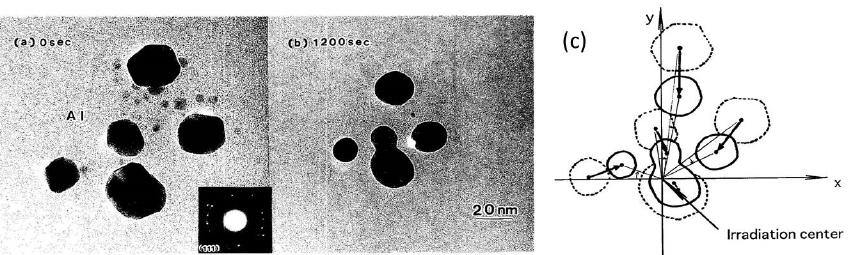
Figure 5. Effects of electron irradiation of a set of Al nanodecahedra inducing migration to the irradiation centre, as well as revolution and rotation. The intensity was 2.1 × 10 20 e/cm 2 s for ( a ) 0 s and ( b ) 1200 s. A schematic view of the effect is shown in ( c ) [6].